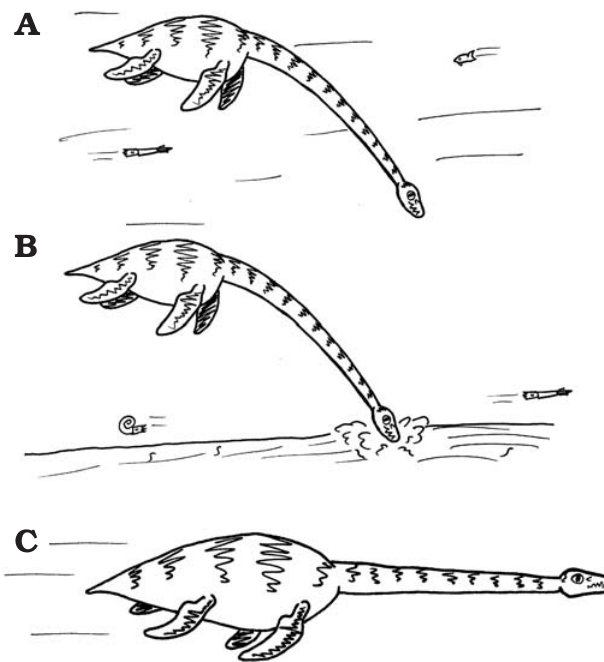
Fig. 11. Lifestyle strategies in plesiosaurs. A . Feeding beneath the body on mesoscopic prey (average diameter 5–10 mm and 100–200 mm), prob- ably shoaling within the water column. B . Feeding on similar sized prey from within soft sediments. C . The escape response, with the neck approx- imately straight in front of the body, and held rigid by the presence of a dorsal ligament system, thereby permitting relatively rapid motion with minimal muscular effort to hold the head and neck anterior of the locomo- tor apparatus. Images from LFN